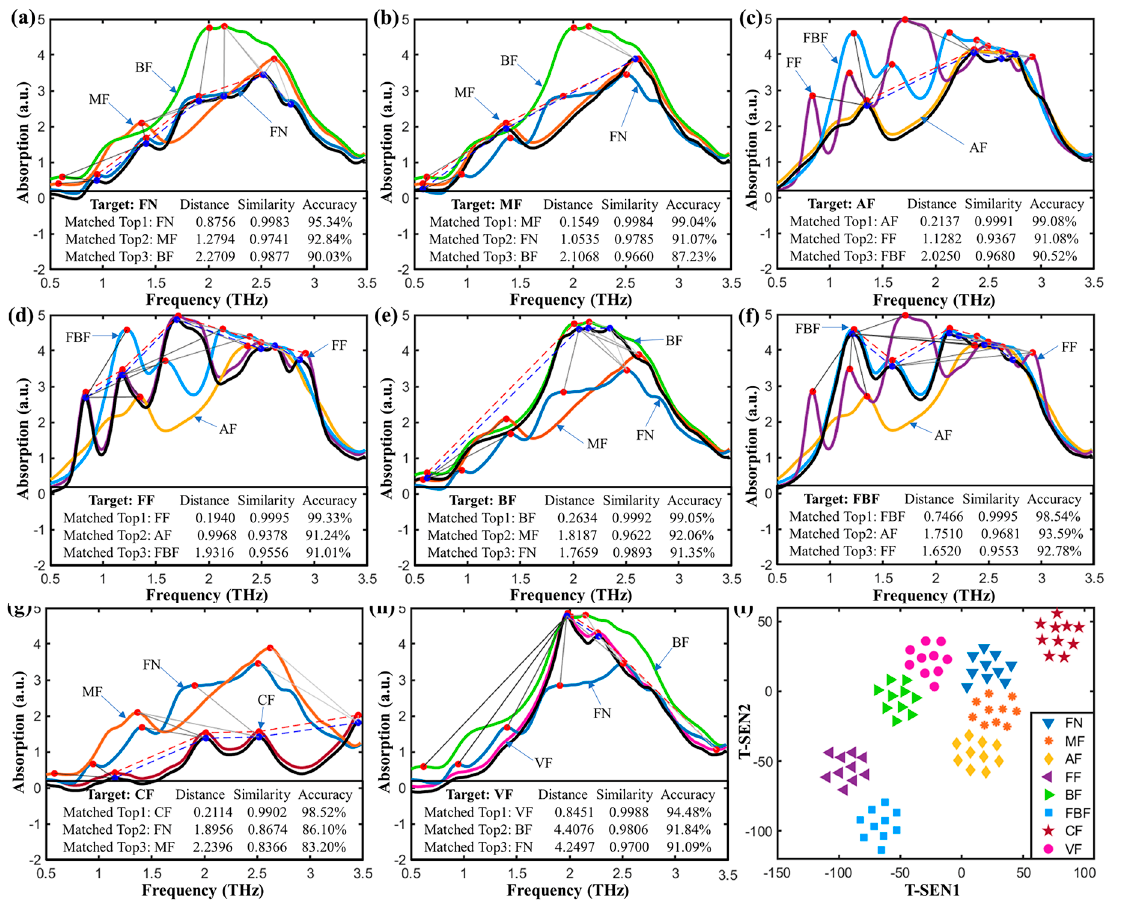
Figure 5. Mass spectral similarity mapping to fentanyl analogs of ( a ) fentanyl, ( b ) methoxyacetylfentanyl, ( c ) acetylfentanyl, ( d ) furanylfentanyl, ( e ) butyrylfentanyl, ( f ) 4-fluoroisobutyrfentanyl, ( g )